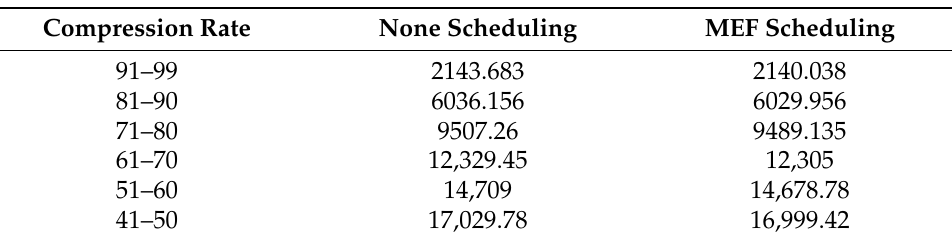
Table 2. Transfer time according to compression rate intervals (ms): No scheduling vs. minimum- extra-first (MEF) scheduling.